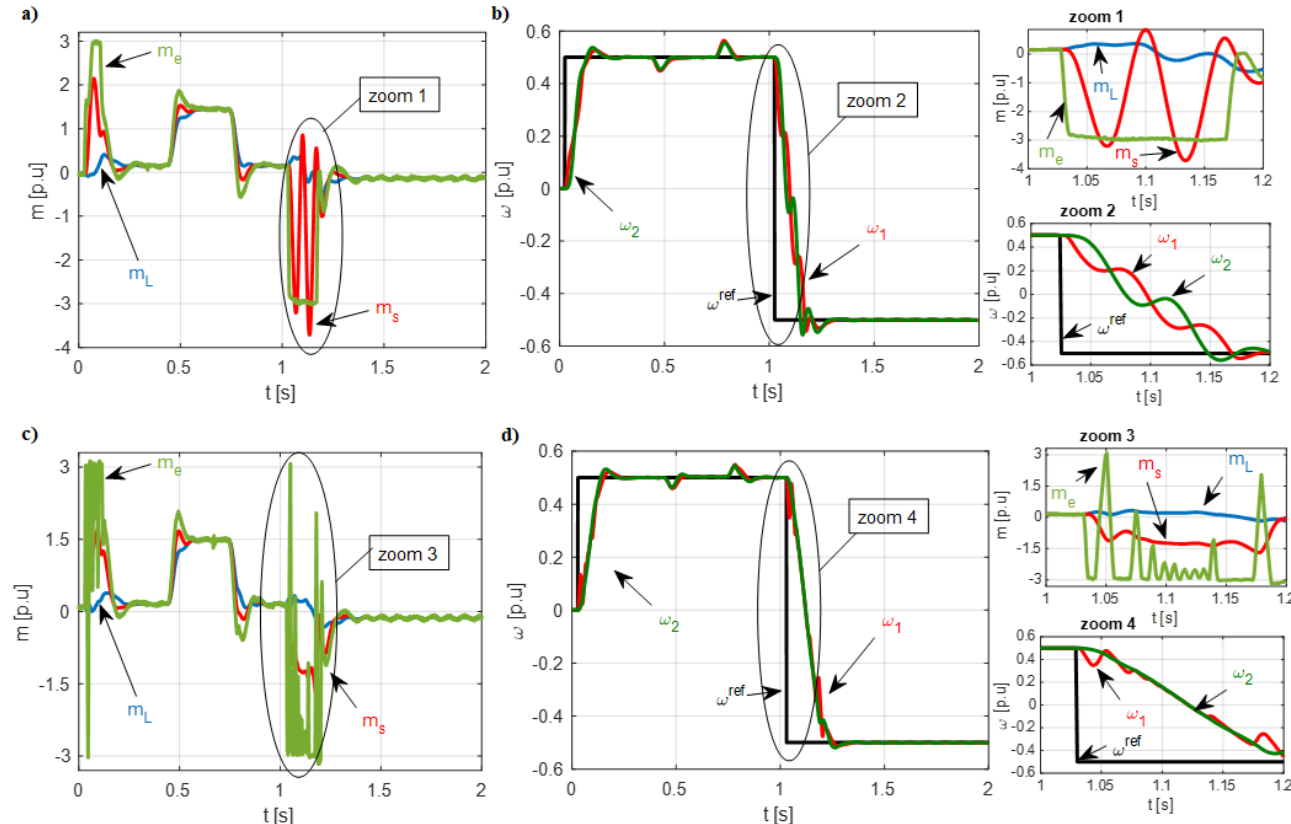
Figure 10. Comparison between PI ( a , b ) and predictive ( c , d ) controllers: ( a ) torque, ( b ) speed.